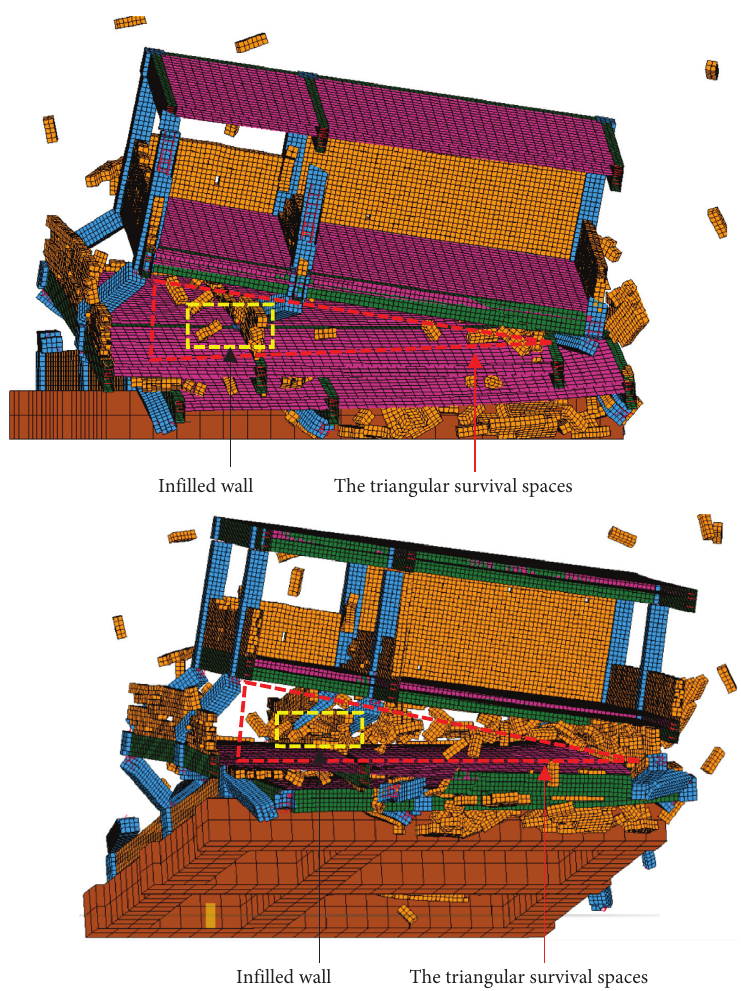
Figure 56: The distribution of triangle survival under the frame